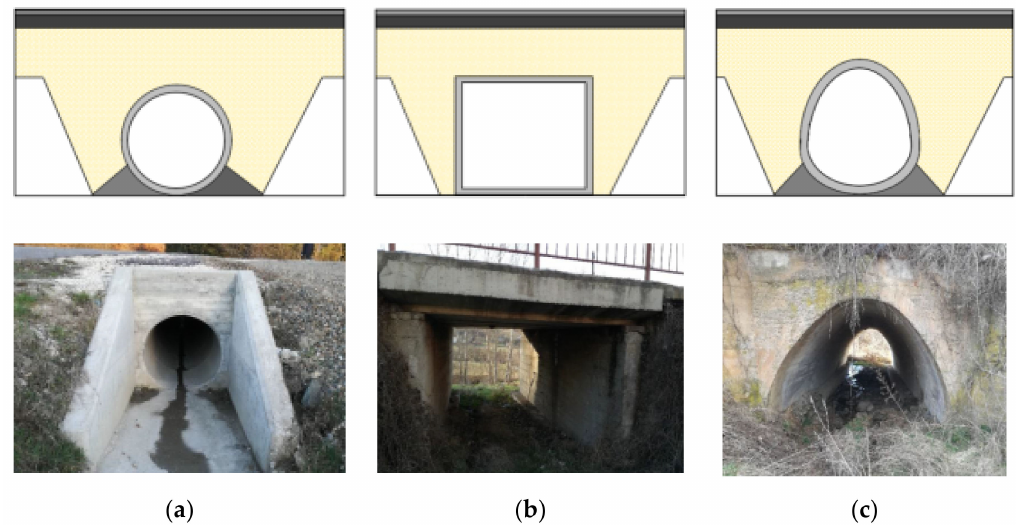
Figure 2. The three characteristic types of road culvert cross-sections (schematic drawings and field photos): pipe ( a ), box ( b ), and pipe-arch ( c